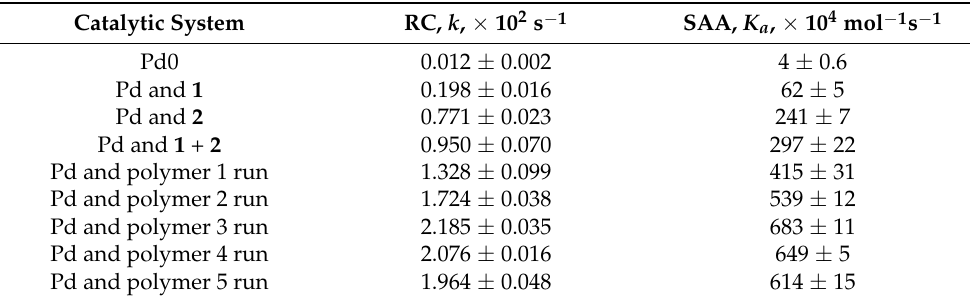
Table 3. Rates of reaction (RC) and specific catalytic activity (SAA) for the reduction in PNP using different catalytic